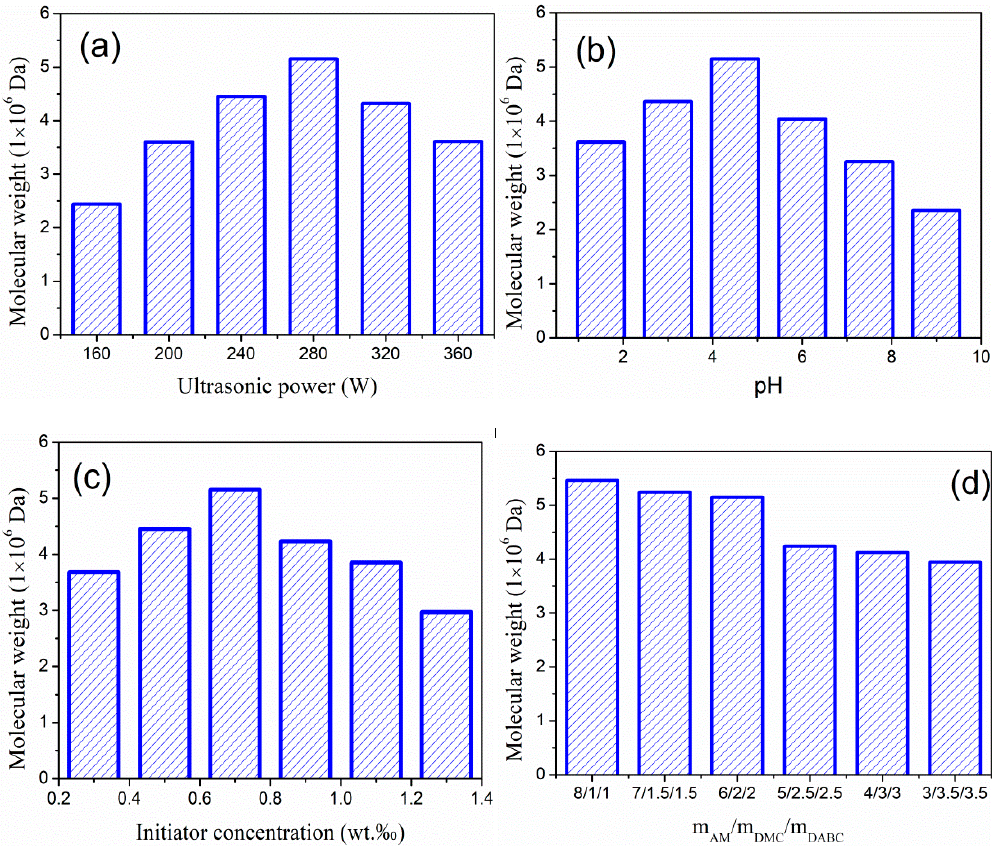
Figure 2. Effects of ( a ) ultrasonic power, ( b ) pH, ( c ) initiator concentration, and ( d ) monomer mass ratio on polymerization.